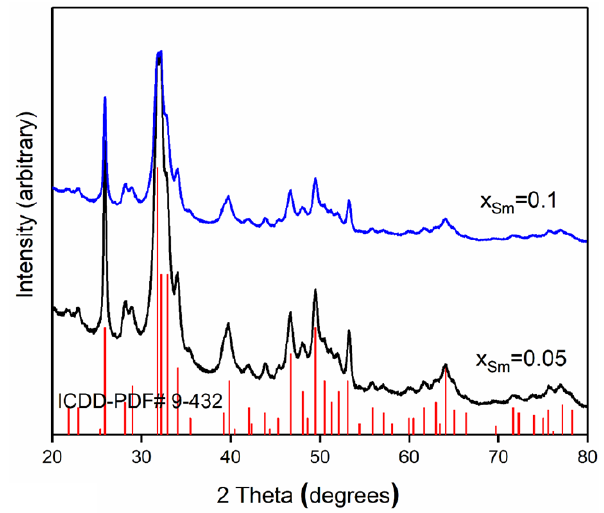
Figure 1. X-ray diffraction pattern of 5SmHAp (x Sm = 0.05) and 10SmHAp (x Sm = 0.1) in the 2θ range from 20° to 80°.